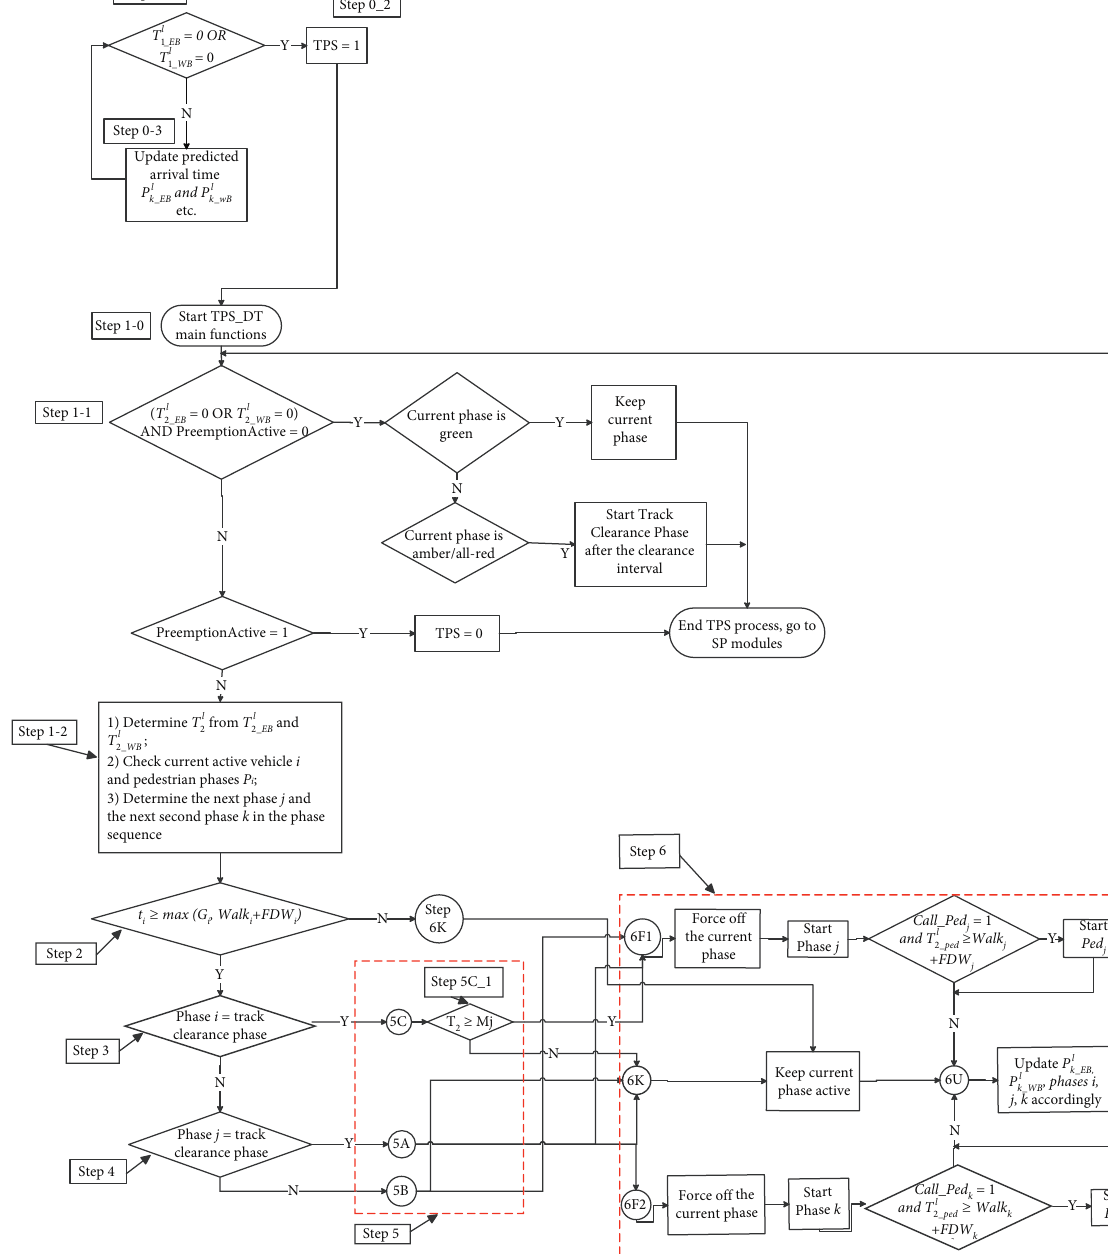
Figure 1: Flowchart of the TPS_DT logic